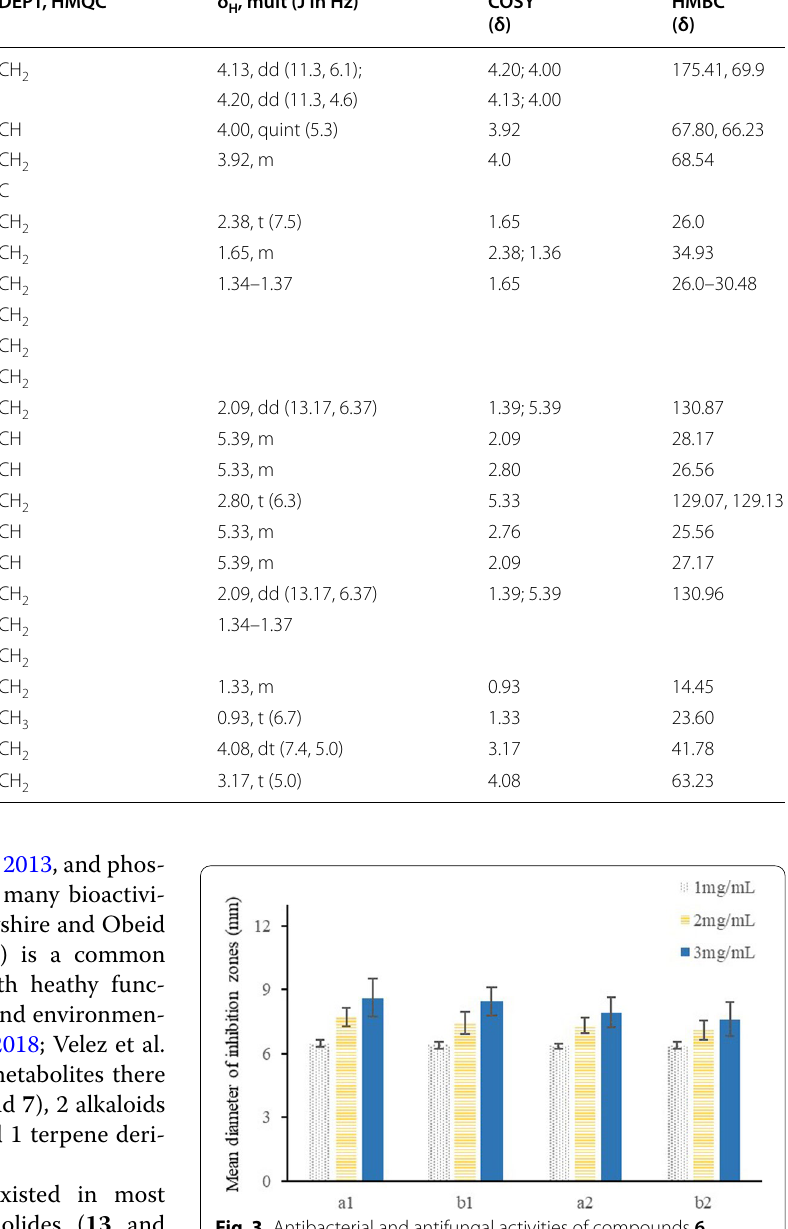
Fig. 3 Antibacterial and antifungal activities of compounds 6 and 7 . The mean diameter of inhibition zones resulting from the antimicrobial activities of compounds 6 and 7. a1 Results of compound 6 against C. albicans . b1 Results of compound 6 against E. coli. a2 Results of compound 7 against C. albicans . b2 Results of compound 7 against E.